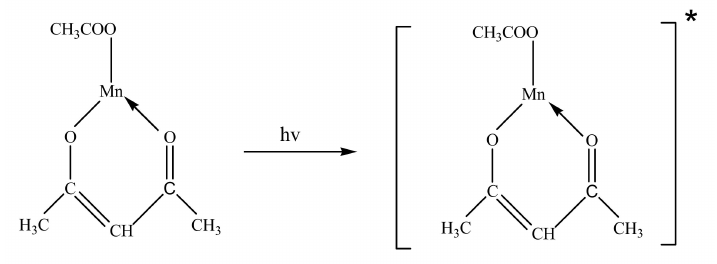
Scheme 2. Expression of electron excitation process.